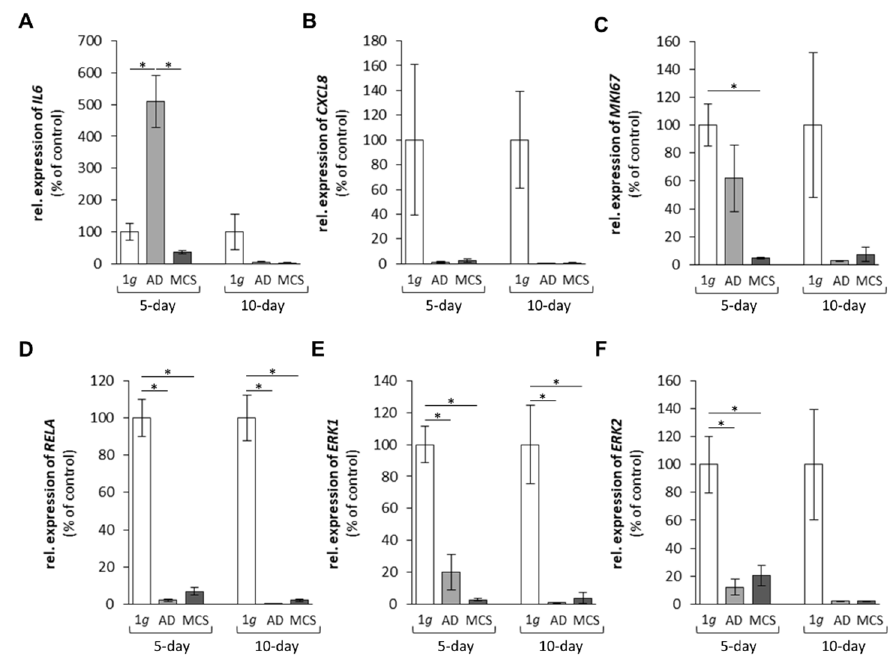
Figure 5. Gene expression of ( A ) IL6 , ( B ) CXCL8 , ( C ) MKI67 , ( D ) RELA , ( E ) ERK1 and ( F ) ERK2 of FTC-133 follicular thyroid cancer cells grown in space on the International Space Station for 5 and 10 days. * p < 0.05 versus 1 g ground control cells. Values are presented as the mean ± standard deviation in percent of 1 g ground controls, which was fixed as 100% for each condition. AD corresponds to adherent cells; MCS corresponds to multicellular spheroids. 5-day spaceflight/1 g ground control samples, n = 3; 10-day spaceflight samples/1 g ground control, n = 2.